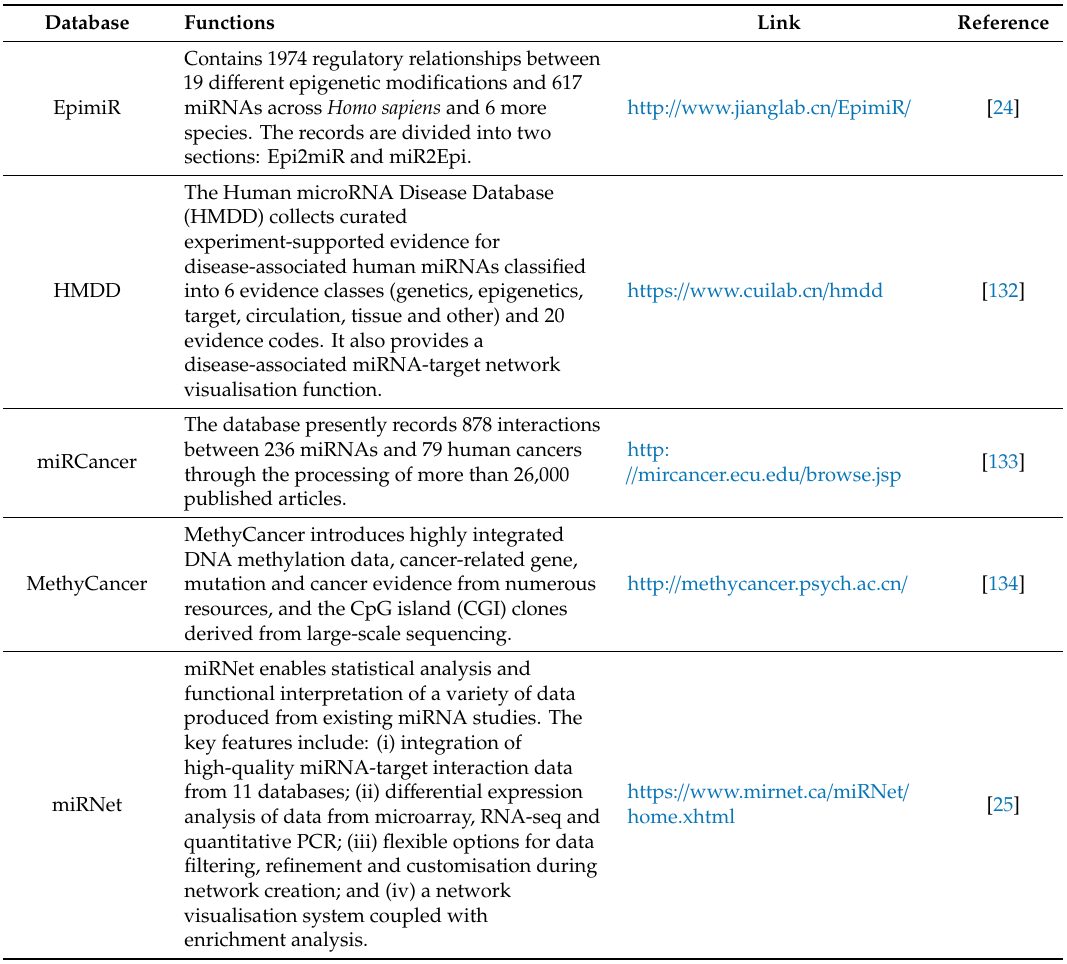
Table 2. Epi-miRNA databases and networking